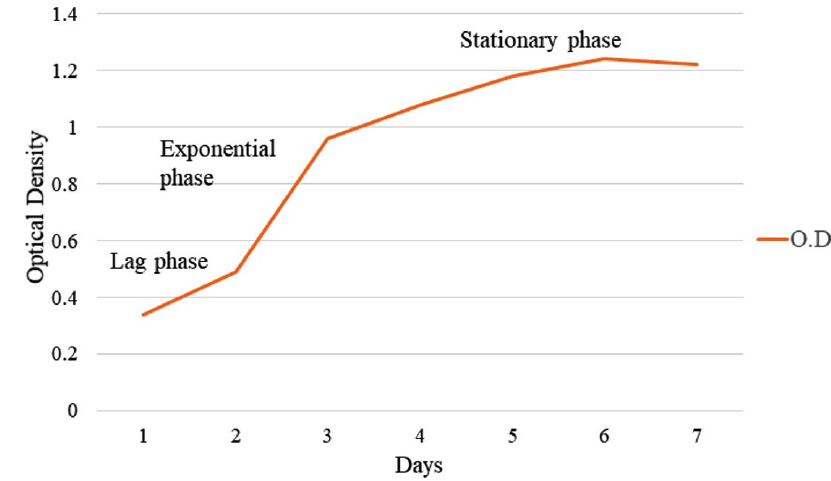
Fig. 2. Growth curve of JRR34